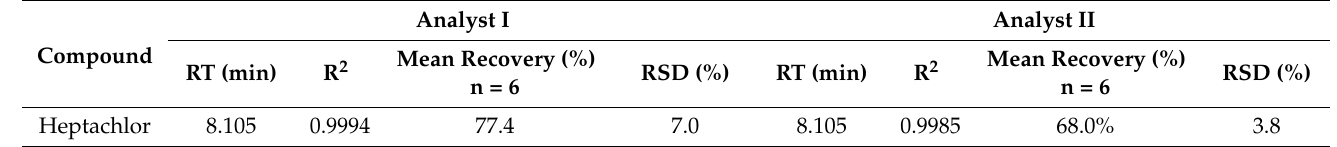
Table 3. Validation of heptachlor at 5.6 ng/g.